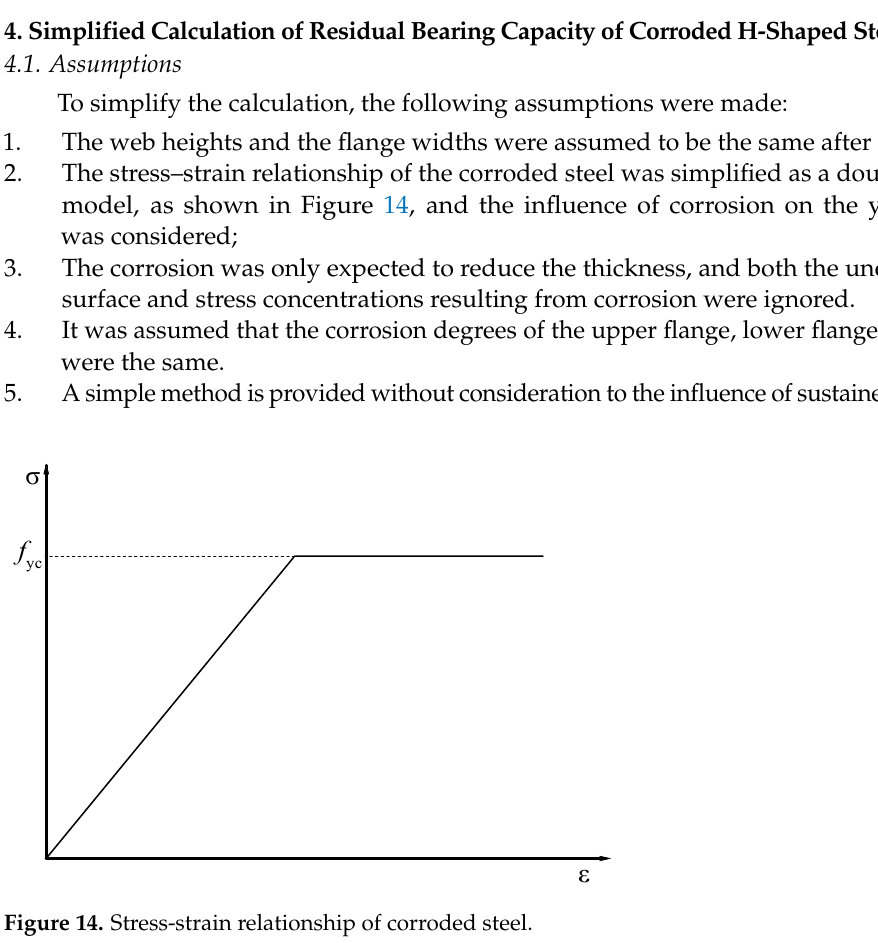
Figure 13. Ductility index and energy dissipation index of corroded steel beams: ( a ) ductility index; ( b ) energy dissipation index.